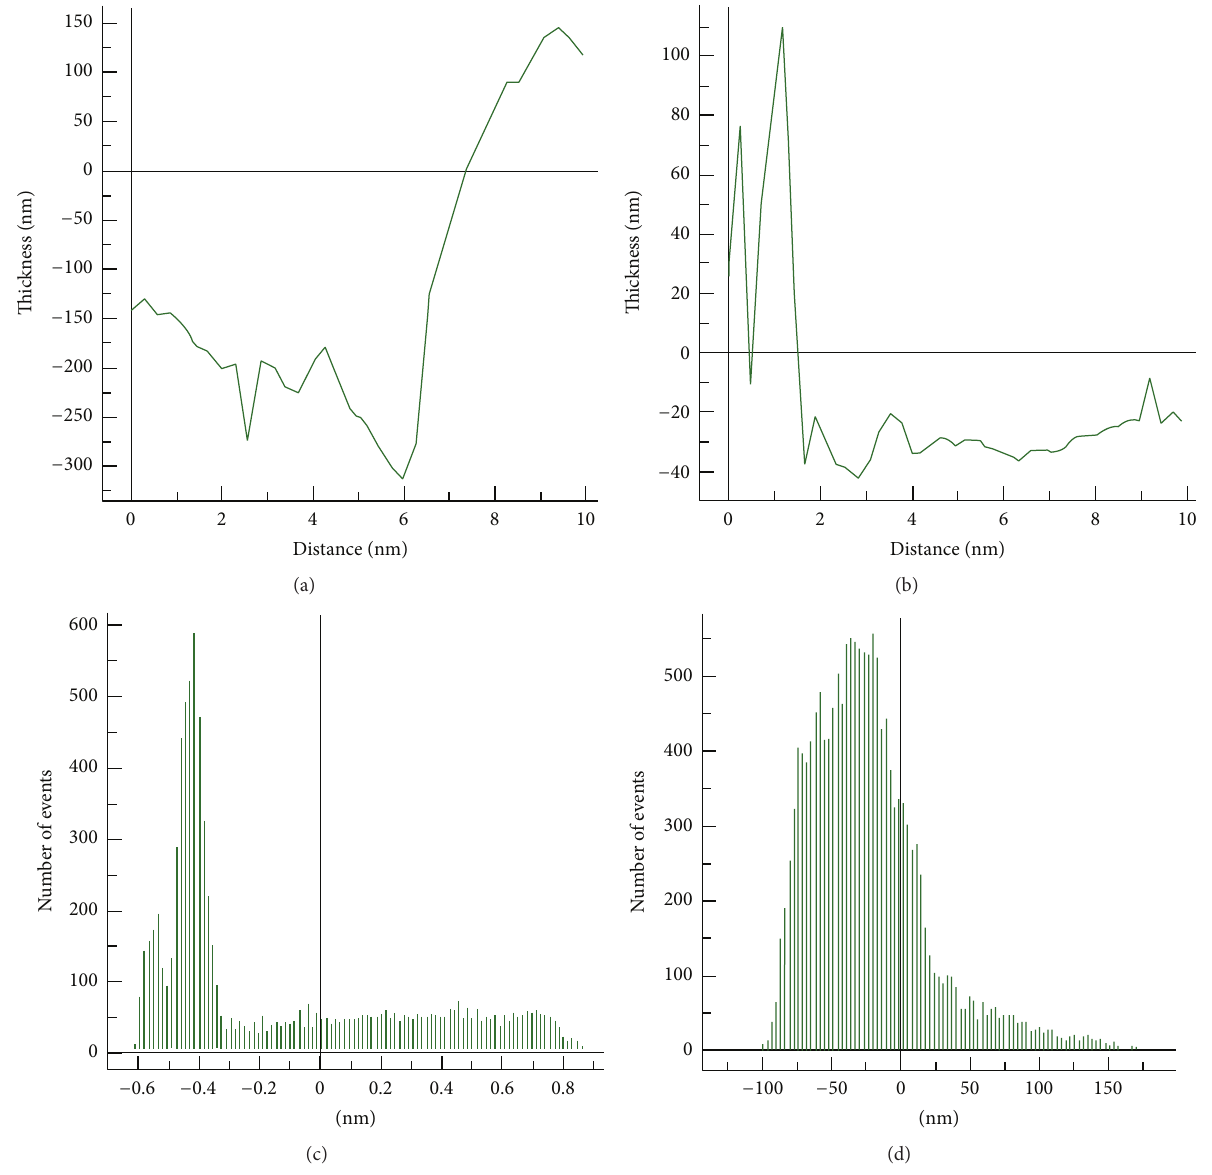
Figure 5: ACM thickness and surface roughness measurement in AFM. (a) Representative figure of Z-scan to measure the thickness of native ACM, (b) Z-scan to measure the thickness of spin coated ACM, (c) representative graph of surface roughness profile in native ACM, and (d) representative graph of surface roughness profile in spin coated